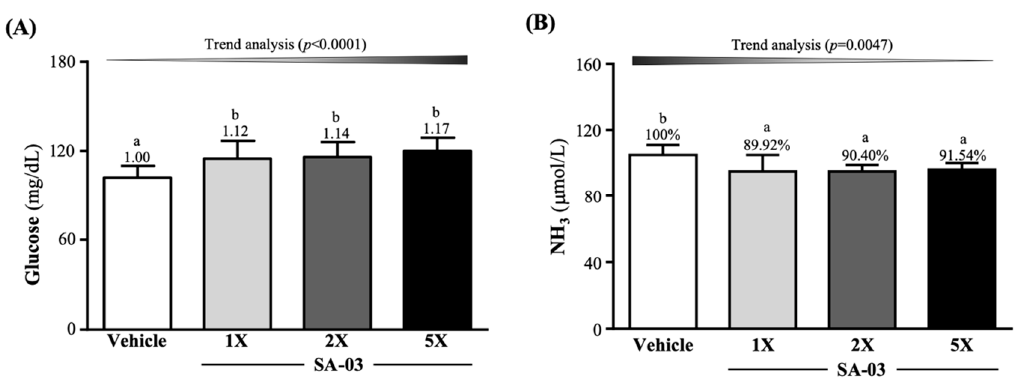
Figure 4. Effect of 4 weeks of SA-03 supplementation on serum ( A ) glucose and ( B ) ammonia (NH 3 ) levels after 10 min of swimming. Data are expressed as mean ± SD ( n = 10 mice per group). Different superscript letters (a, b) indicate significant difference ( p < 0.05).